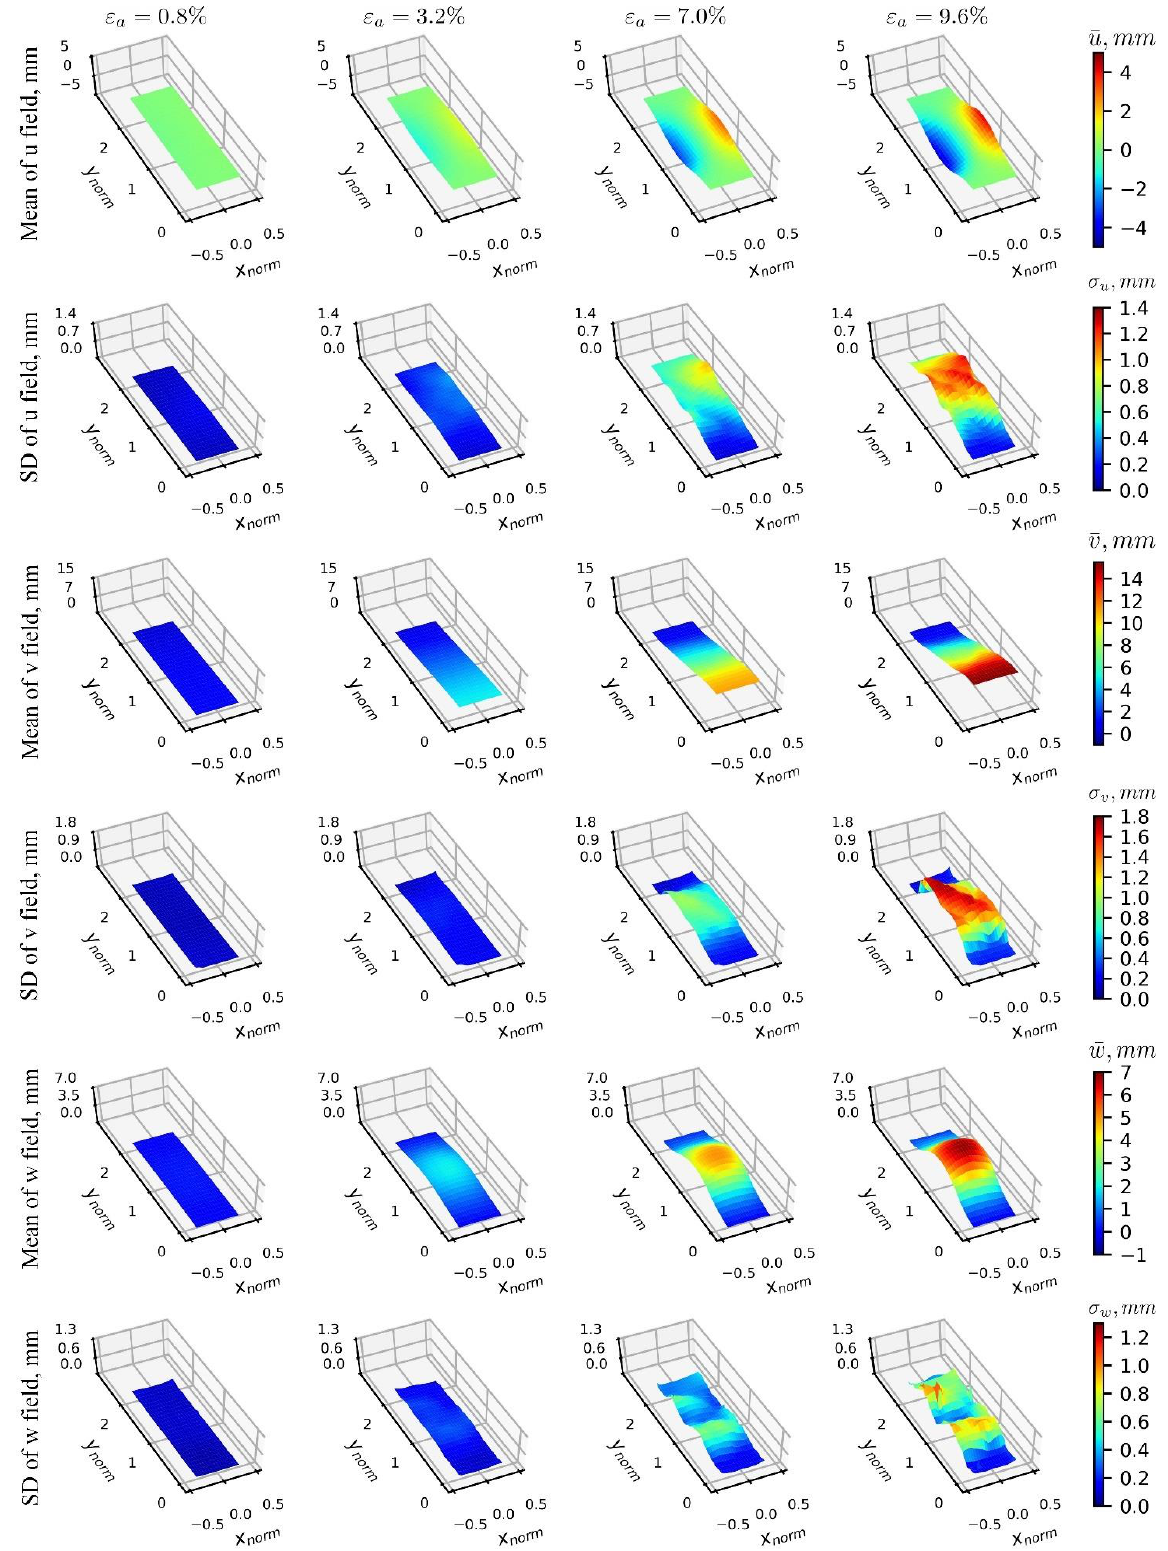
Figure 13. Mean and standard deviation distributions of 3D-T data ensemble under the Cartesian coordinate system, where each column defines a specific loading stage, and each row shows either the mean or standard deviation of a displacement’s data ensemble.